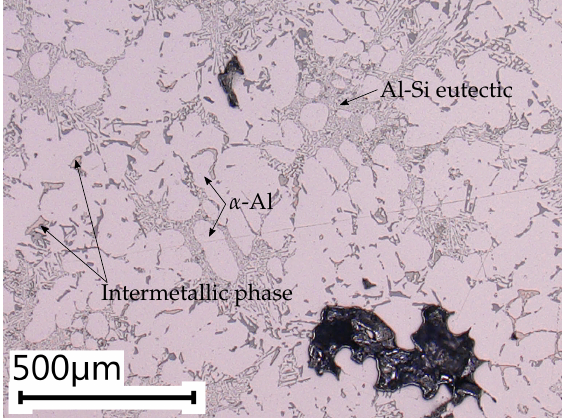
Figure 3. Representative metallographical specimen of position B with α -Al, Al-Si eutectic and intermetallic